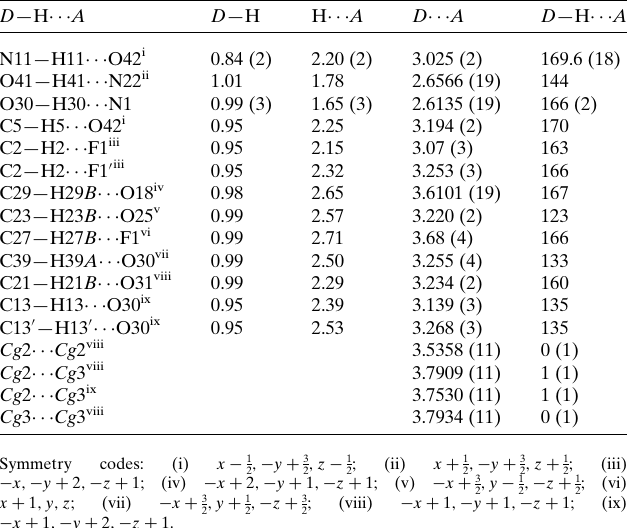
Table 1 Hydrogen-bond geometry (A˚ , (cid:3) ).